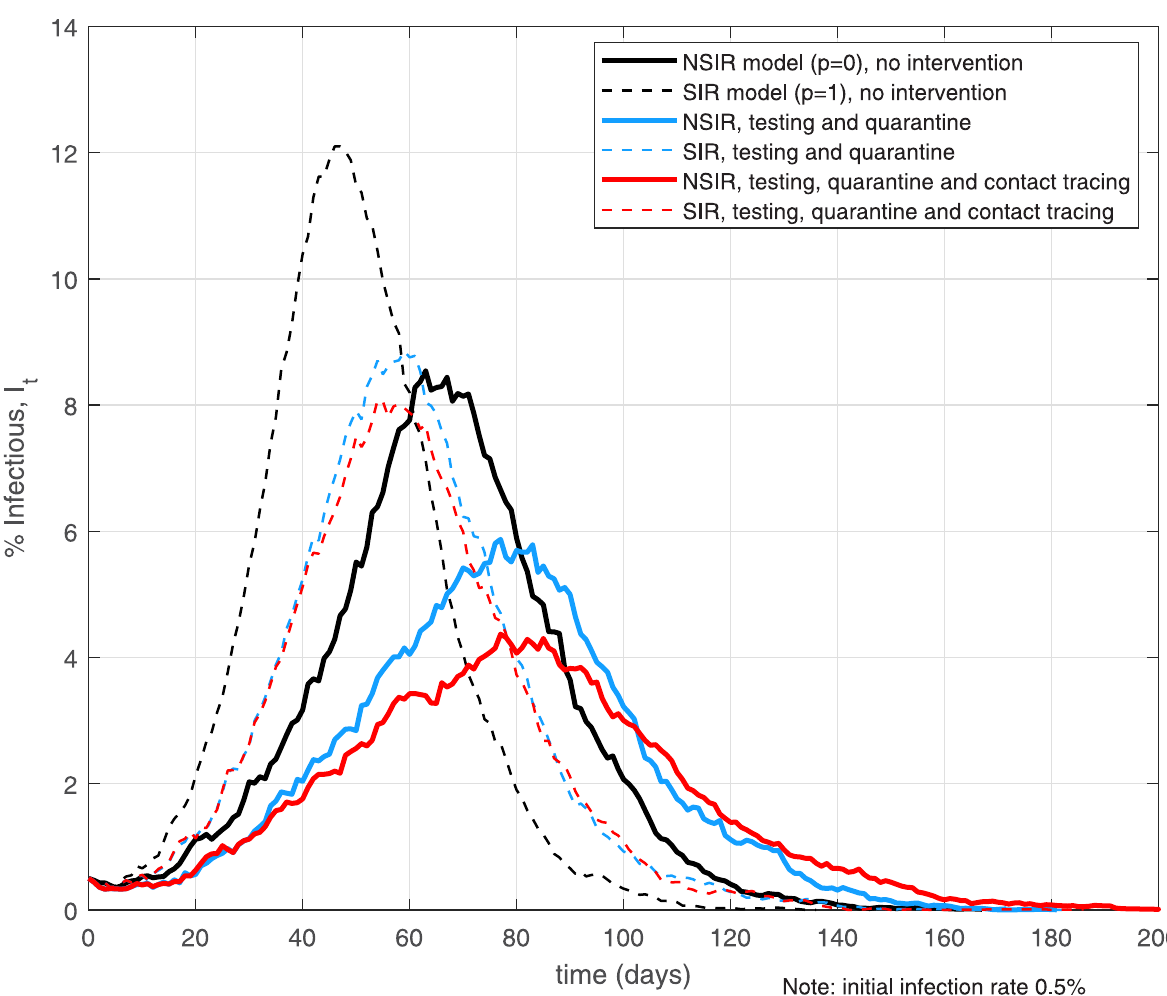
Fig 3. No intervention, mass testing, quarantine and contact tracing. Notes: the black lines assume no policy interventions or behavioral responses. The light blue lines assume mass testing rate θ = 0.05 and putting positive cases (state P ) in quarantine, network Q . The red lines add contact tracing at rate ϕ = 0.1 to the testing and quarantine